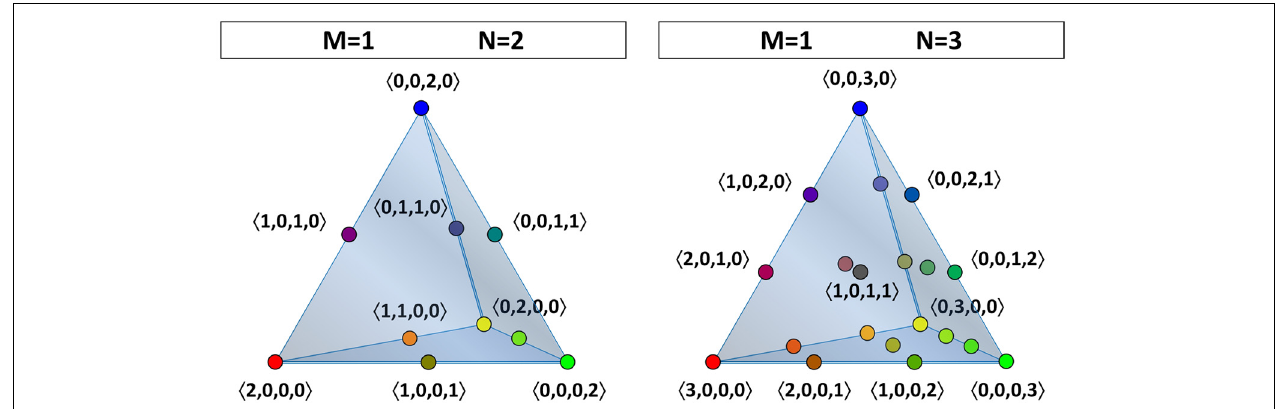
FIGURE 1 | The belief space or opinion-profile space (OPS) for the theories in a language with one atomic proposition ( M = 1) can be visualized as a discrete grid in a tetrahedral volume. The number of grid points depends on the population size. The OPS of a population of two